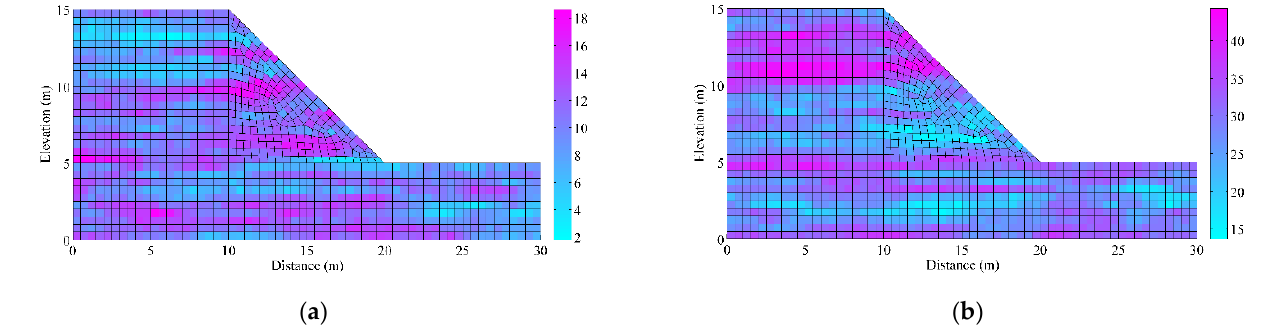
Figure 12. A typical realizations of CCRF associated with WB margins. ( a ) Random field of c . ( b ) Random field of φ .